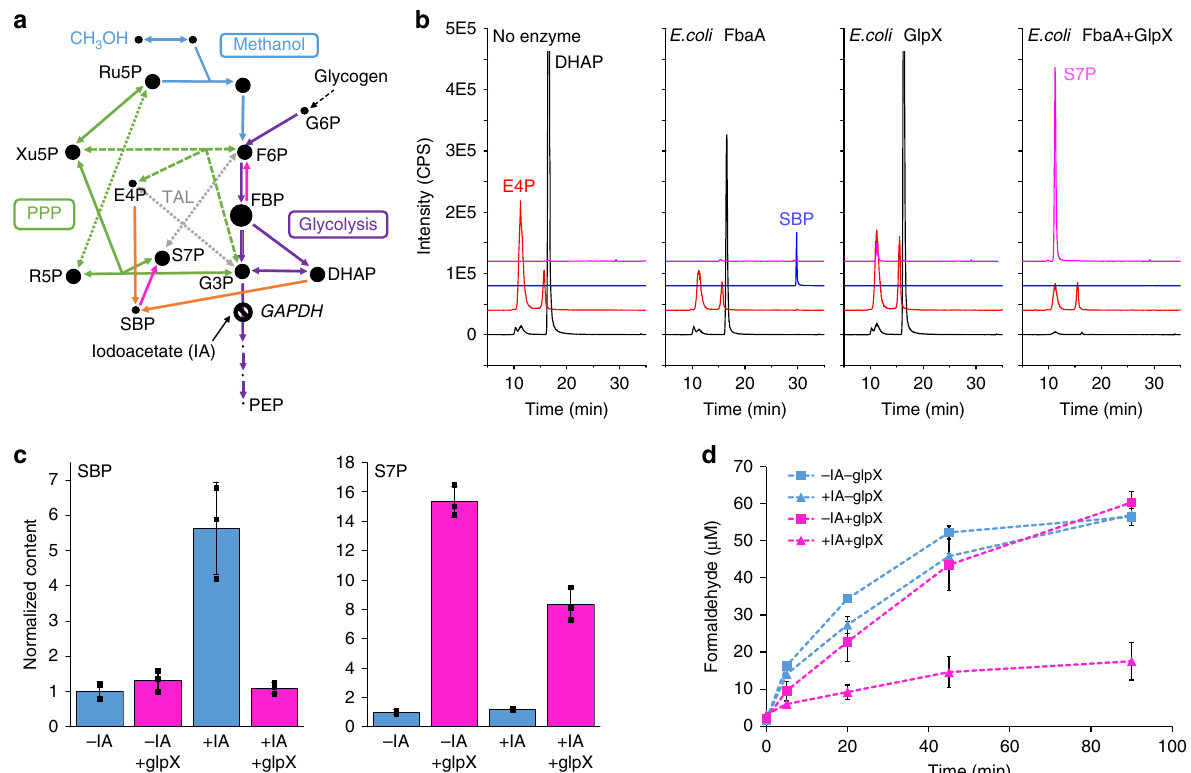
Fig. 5 Ru5P regeneration is mediated by activation of the SBPase variant of the RuMP pathway. a Pathways involved in methanol metabolism, additionally showing the sedoheptulose bisphosphatase (SBPase) variant of the ribulose monophosphate (RuMP) pathway, where SBP is produced from DHAP and E4P by FbaA (orange line), and dephosphorylated to S7P by SBPase (pink line), compared to the transaldolase (TAL) pathway (gray line), where S7P is produced from F6P and E4P. Dot sizes indicate relative metabolite concentrations in cells treated with IA and overexpressing glpX , compared to untreated cells not overexpressing glpX . b LC-MS/MS analysis of assays with puri fi ed E. coli FbaA and GlpX, demonstrating that GlpX has SBPase activity. Black = DHAP, Red = E4P, Blue = SBP, Pink = S7P. c Relative SBP (left) and S7P (right) levels in cells treated with or without iodoacetate and expressing glpX (pink) or not (blue). d Formaldehyde timecourse in transaldolase-de fi cient E. coli cells (MG1655(DE3) Δ frmA talA(K131A) Δ talB) treated with 250 mM methanol, either expressing (pink) or not expressing (blue) glpX. Triangles denote cells treated with IA, and squares denote untreated cells. Error bars represent s.d. of n = 3 biological replicates (three individual